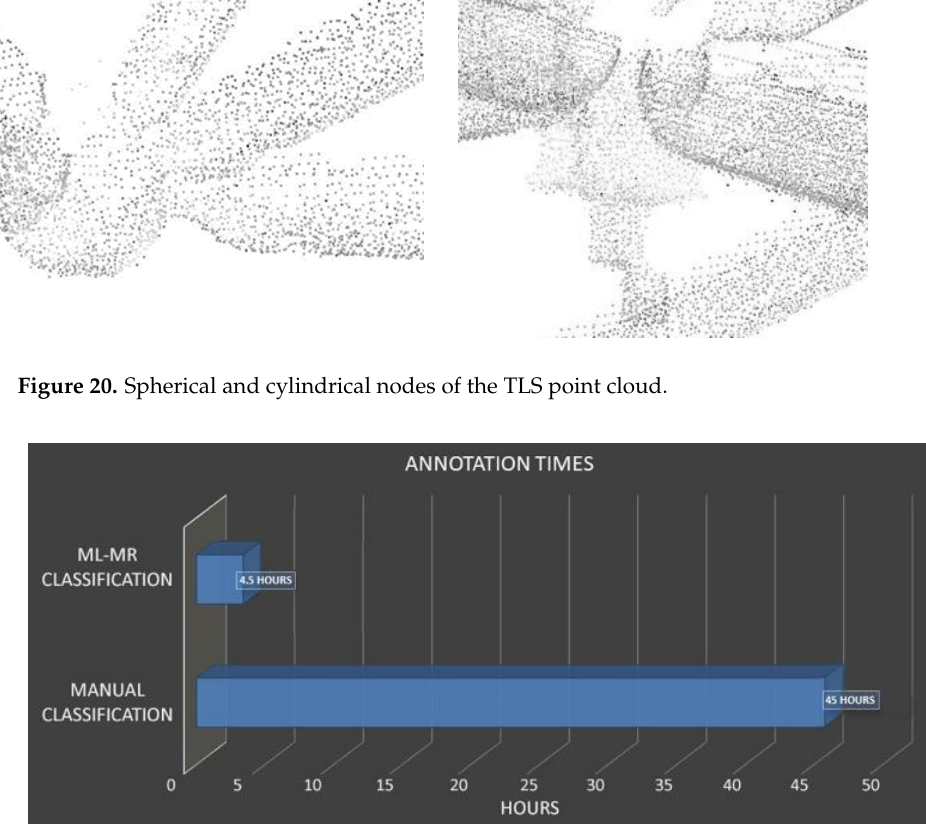
Table 2. Estimate of the ML-MR classification time via RF for a single classification level (in bold the total time required).